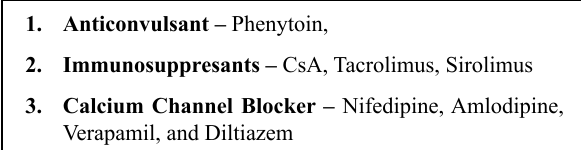
Table 4: Three classes of drugs associated with